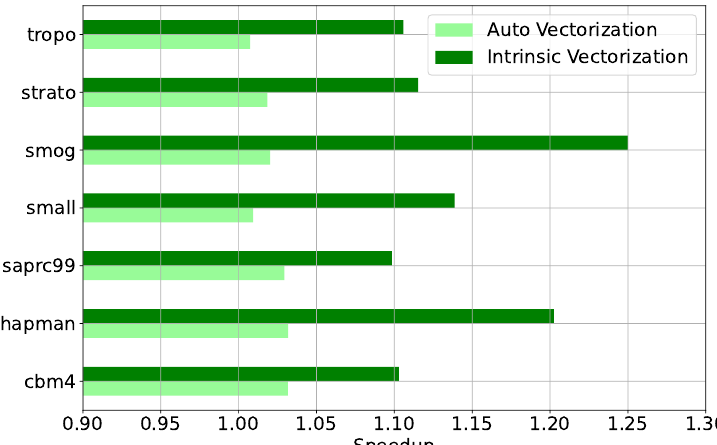
Figure 4. Measured speed-up for the seven chemical mechanisms with mixed-precision Rodas4 at RelTol = 10 − 2 by automatic vectorisation (light green) and explicit vectorisation through the use of intrinsic functions (dark green) with respect to scalar